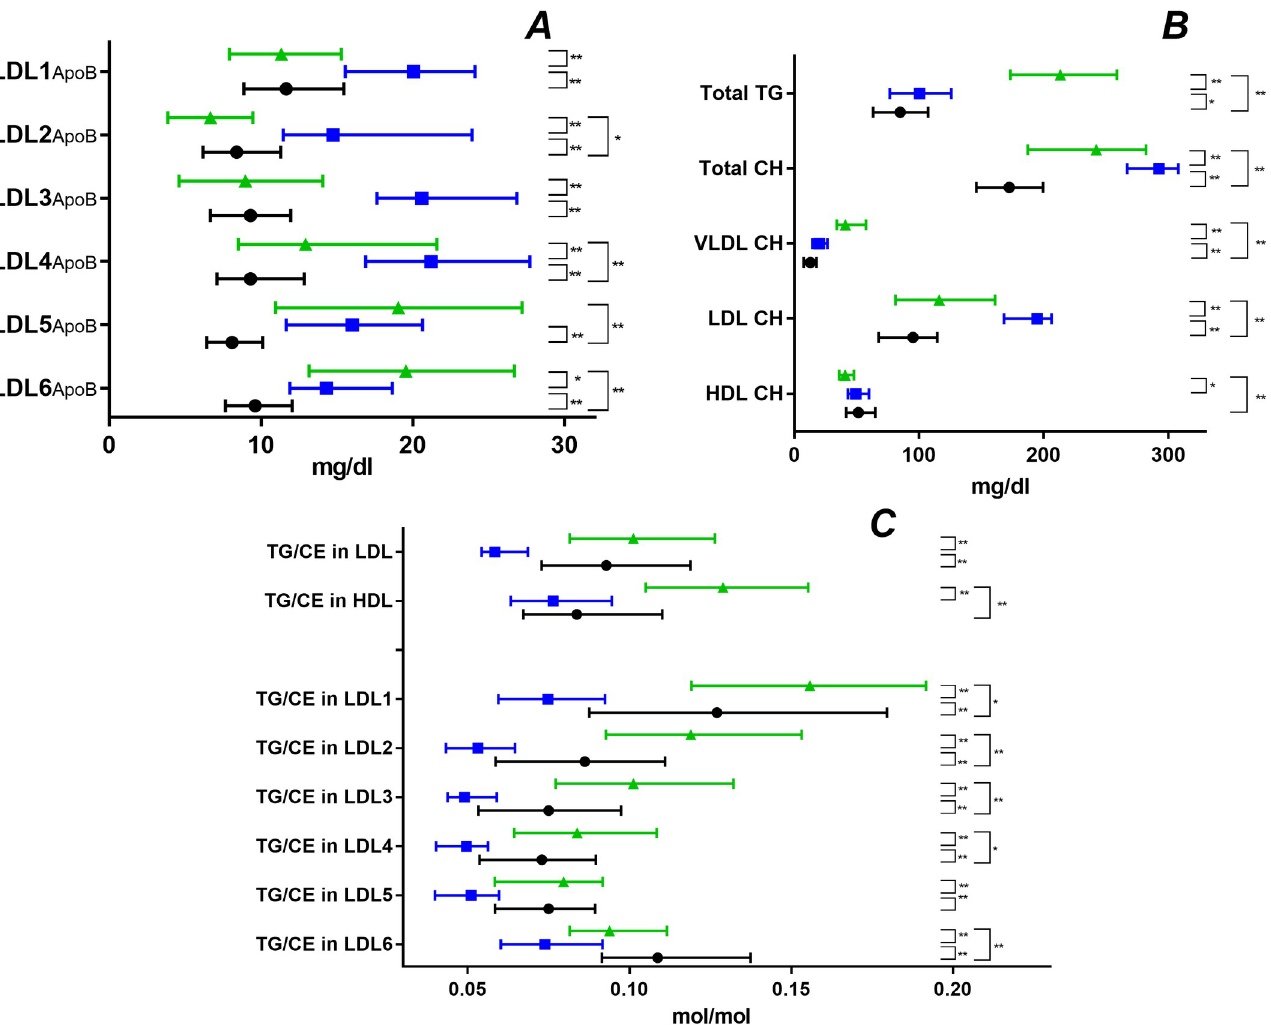
Fig 2. Lipoprotein characteristics. Quartiles in NL (black), HTG (green) and HCH (blue). (A) ApoB in the LDL subfractions, (B) CH and TG in total and CH in lipoprotein fractions (C) TG/CE ratios in HDL, LDL and its subfractions. Statistical significance determined by Mann-Whitney-U test ( � p < 0.05, �� p < 0.01).